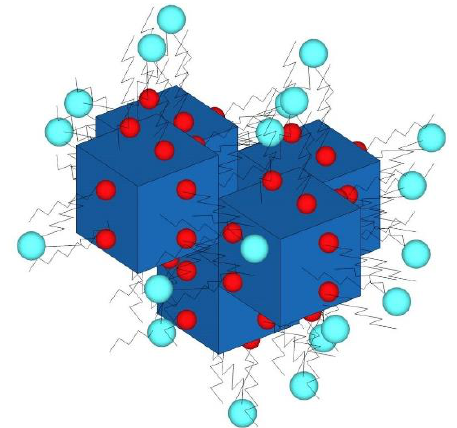
Figure 5. Schematic diagram of the as-synthesized lipid complex. Red: oleylamine (OA) polar head; blue: phospholipid polar head. The nucleus is formed by some individual particles of PB (blue). These are coated with molecules of OA (red), and the OA molecules are covered by phospholipids with the polar head at the external face (cyan).